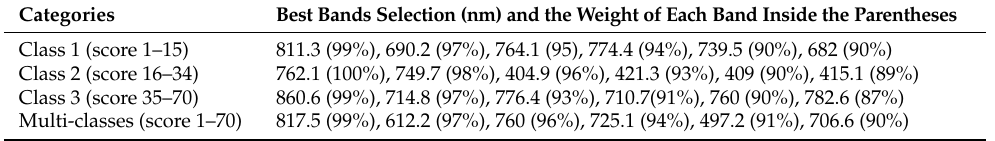
Table 2. Best wavelength selections were chosen in different severity classes and binary classes using random forest classifier